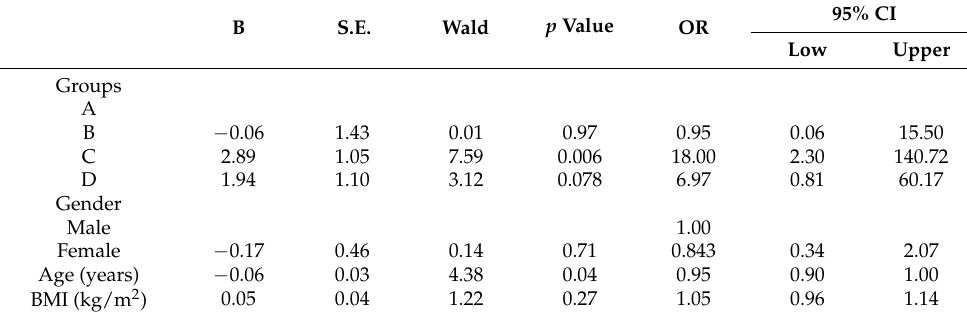
Table 4. Odds ratio for risk of systemic reactions after a vaccine